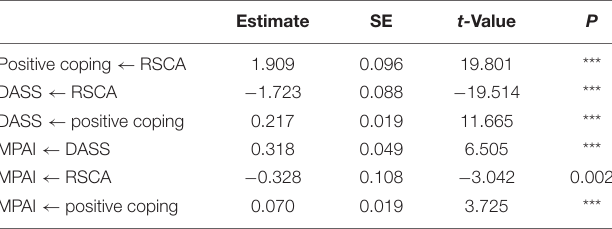
TABLE 2 | Basic characteristics and measure scores.